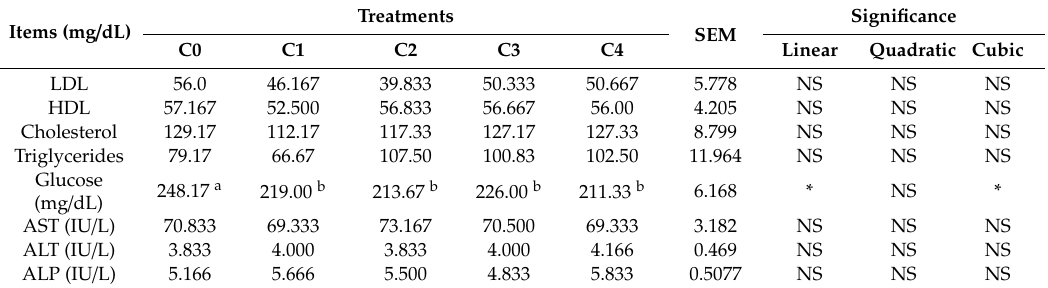
Table 3. E ff ect of chromium propionate on blood metabolites of broilers at slaughtering.